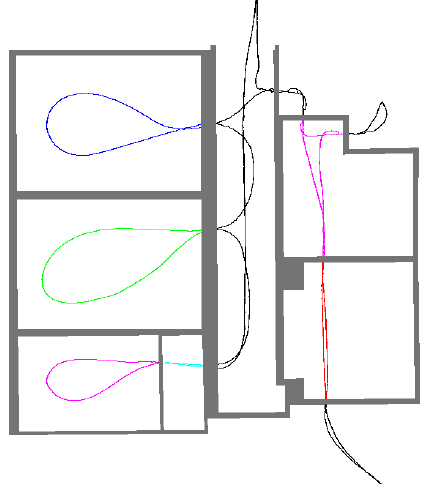
Figure 6. Subdivision of the acquisition path into sub-paths for each room (points belonging to each room are colored in a different way).